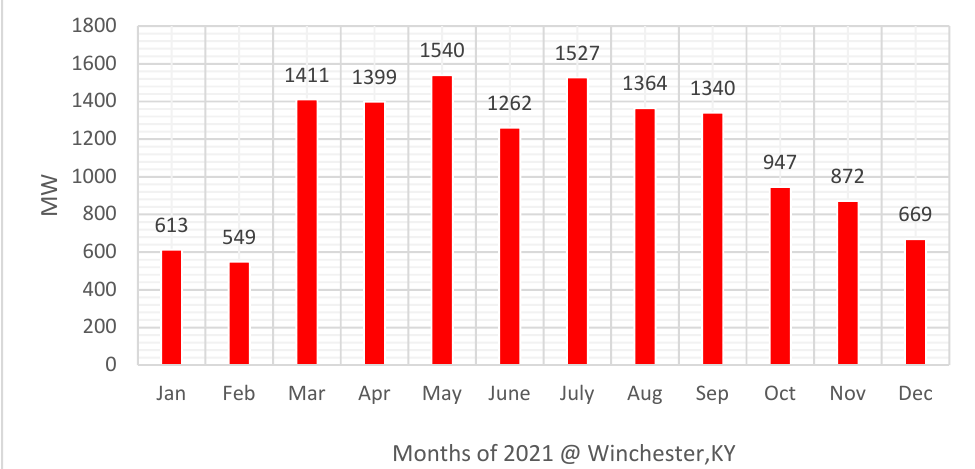
Figure 5. Yearly Output of Solar Farm One: Winchester, KY for 2021 [15].